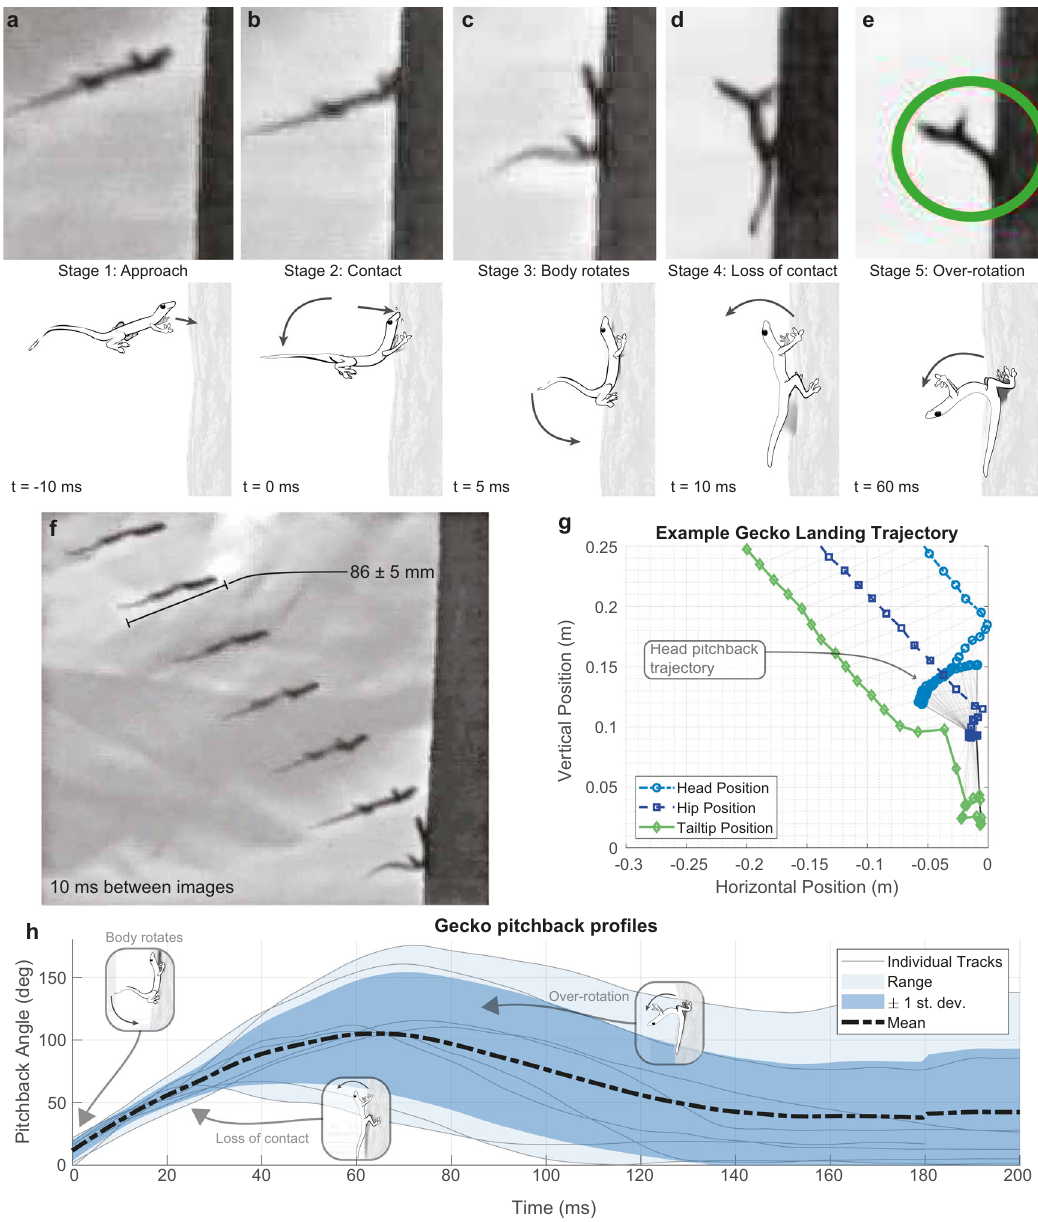
Fig. 2 Geckos H. platyurus landing on a vertical tree trunk in a Southeast Asian lowland tropical rainforest. (Supplementary Movie 1). a – e Postural sequence of the landing maneuver and FAR: a motion sequence of the gecko approaching the vertical target at positive angle of attack and b – e alighting onto tree trunk. b First impact occurred with the head and anterior trunk. c Body rotated downward and rear legs attached to the tree trunk. d Front legs slipped off and the gecko ’ s torso rotated with its back toward the forest fl oor as the tail made contact with the wall. e Maximum pitch-back was attained and the animal momentarily came to rest before its torso returned to the tree trunk so that the front legs regained a foothold. f Example approach trajectory, showing an image sequence with 10 ms between stills. g Example of body position from landing to pitch-back ( θ ). h Body pitch-back during FAR plotted over time ( n =